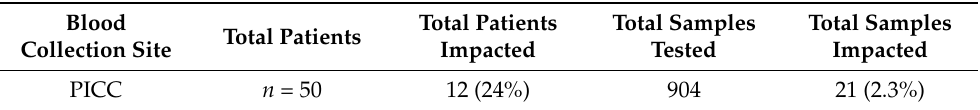
Table 2. Information of DD-infused patients with impacted E-sCr in longitudinal comparison with BUN or potassium results.